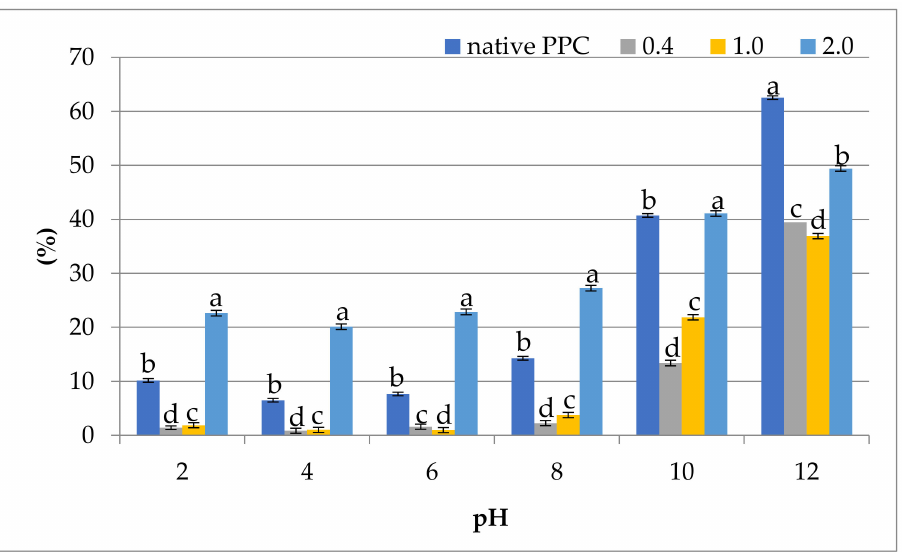
Figure 2. Effect of anhydride-to-protein ratio on protein solubility (PS) at different pH of native and acetylated PPC. Values are means ± standard deviation; a,b,c,d —the same letters within the same pH were not significantly different; PPC—pumpkin protein concentrate; 0.4, 1.0, 2.0—pumpkin protein preparations after acetylation conducted with different concentrations of acetic anhydride